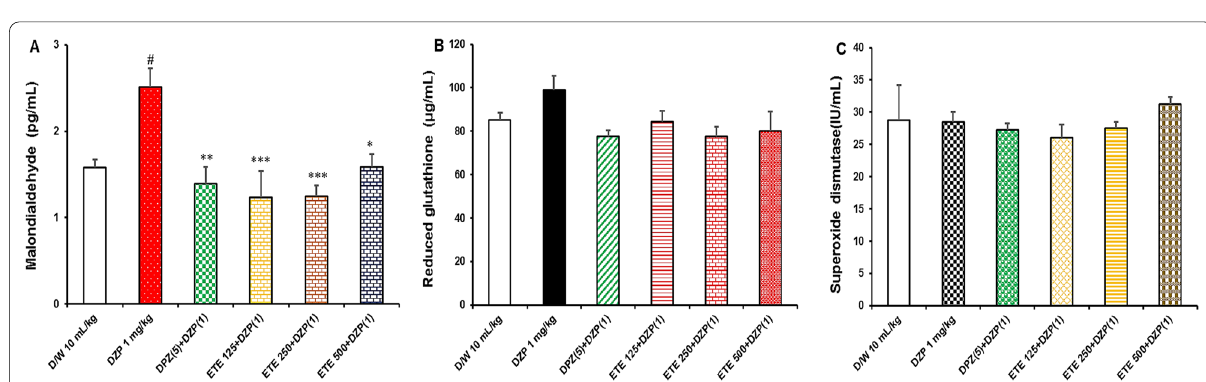
Fig. 5 Effect of Eragrostis tremula extract on oxidative stress markers following diazepam-induced amnesia in mice. A Reduced glutathione, C versus DZP alone group—one-way ANOVA followed by Bonferroni’s test, n tremula